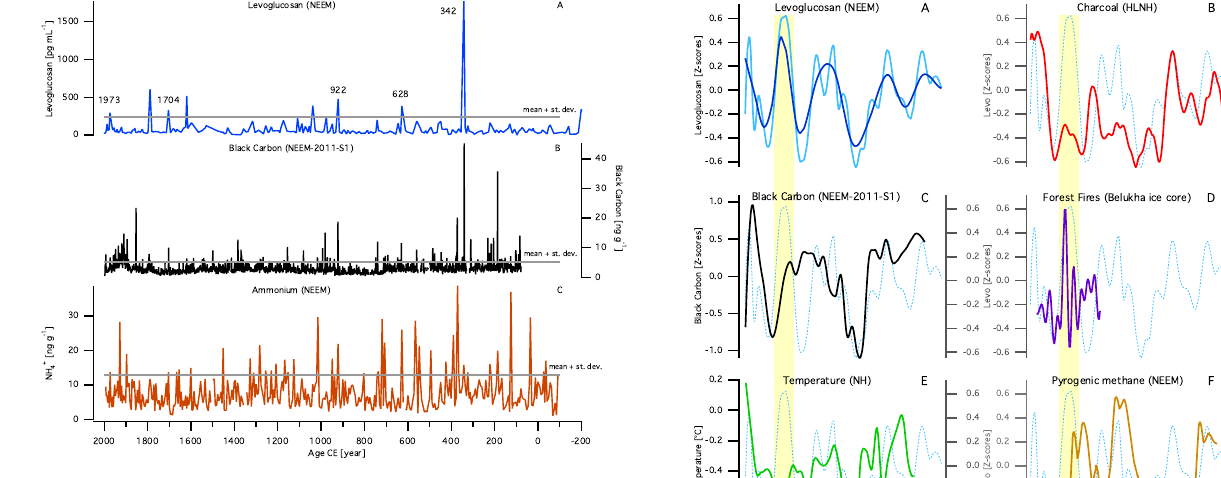
Figure 2. (a) Levoglucosan concentration profile measured in the deep NEEM core including the dates of megafires coincident be- tween levoglucosan, black carbon and ammonium; (b) black carbon concentration profile measured in the NEEM-2011-S1 ice core; (c) ammonium concentration profile in the deep NEEM ice core.